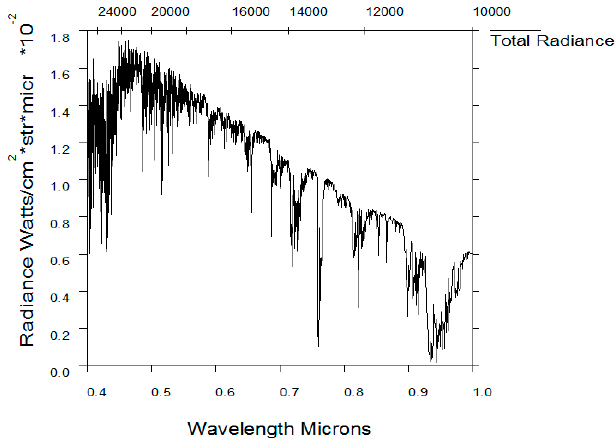
Figure 1. The spectral radiance curve of the entrance pupil.